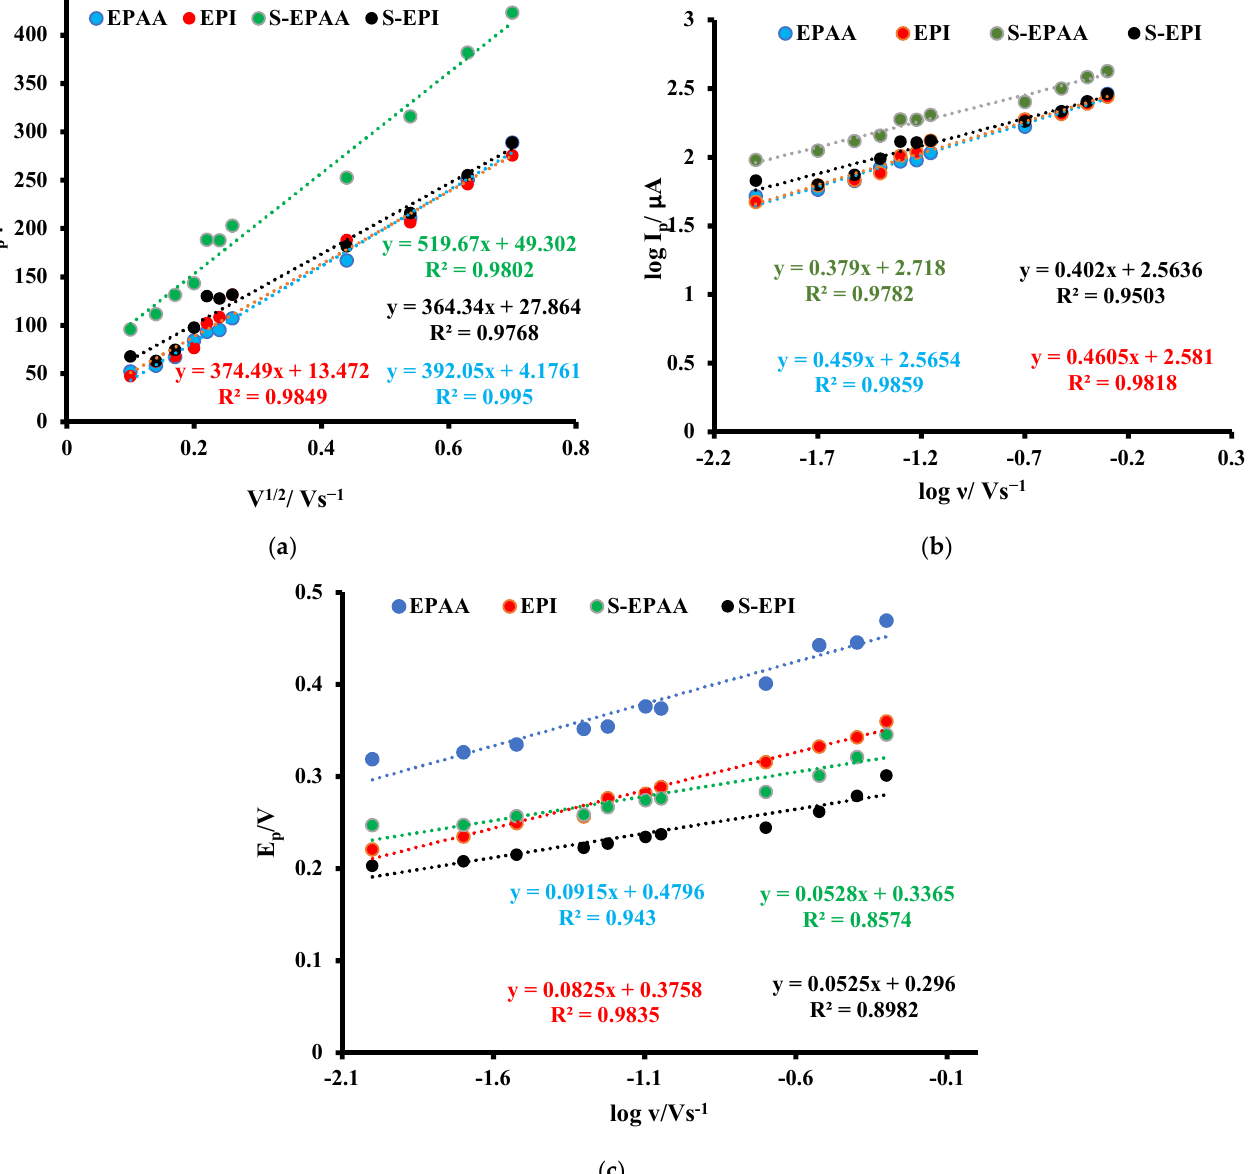
Figure 6. The plot between ( a ) Ip vs. ν 1/2 ( b ) log Ip vs log ν and ( c ) Ep vs log ν for cyclic voltammograms obtained from EPAA, EPI, S-EPAA and S-EPI in PBS (pH 7) at different scan rates in the presence of 2 mM AA.